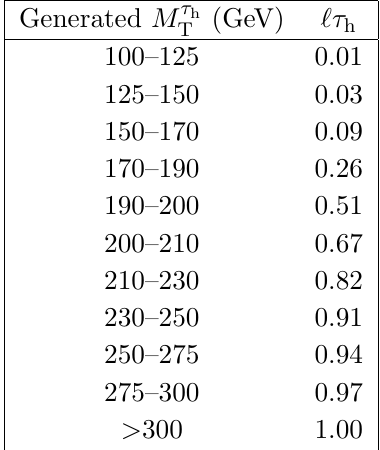
Table 12 . E(cid:14)ciencies of the M (cid:28) h